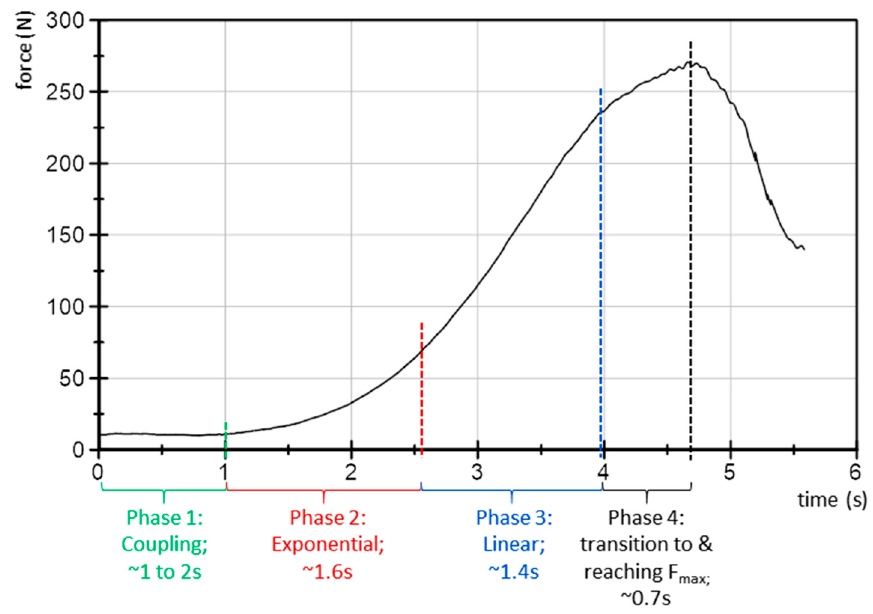
Figure 13. Suggestion for a standardized force profile including the proposed four phases considering the neurophysiological characteristics of forward controlling.